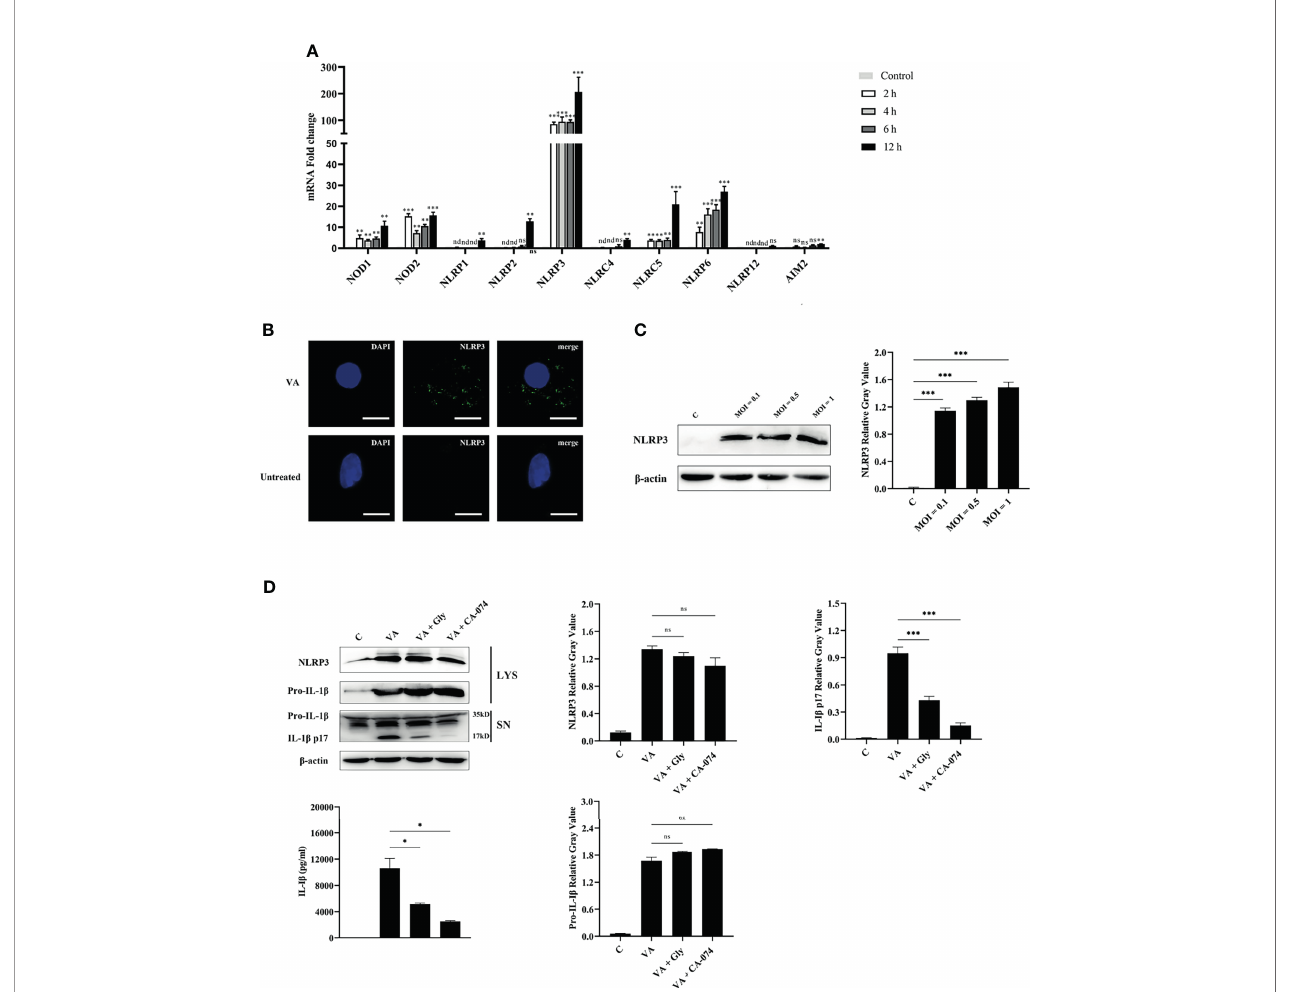
FIGURE 3 | NLRP3 in fl ammasome was activated in V. alginolyticus -infected macrophages and played vital roles in IL-1 b secretion. (A) Macrophages were infected with V. alginolyticus at an MOI of 1 for 2, 4, 6, and 12 h, and then the mRNA levels of patterns recognize receptors including NOD1, NOD2, NLRP1, NLRP2, NLRP3, NLRC4, NLRC5, NLRC6, NLRP12, and AIM2 were detected using qPCR. Data represented the mRNA fold change compared with the control group standardized to b -actin. (B) Mouse peritoneal macrophages were infected with V. alginolyticus (MOI = 1) for 12 h, and then the localization of NLRP3 protein was visualized by immuno fl uorescent staining. The green signals represent FITC-labeled NLRP3 protein, and the blue signals represent DAPI-stained nucleus. (C) Macrophages were infected for 12 h with V. alginolyticus at MOIs of 0.1, 0.5, and 1. The levels of NLRP3 in the cell lysates were detected by Western blotting, and the relative gray value was analyzed using ImageJ. (D) Mouse peritoneal macrophages were pretreated with 50 m M glyburide or 25 m M CA-074 methyl ester for 1 h and then infected with V. alginolyticus at a MOI of 1 for 12 h The protein expression levels of NLRP3, pro-IL-1 b , and IL-1 b were examined by Western blotting combined relative gray analysis, and the IL-1 b levels in the cell supernatants were also detected by ELISA. Data were representative of at least three repetitive experiments. * p < 0.05, ** p < 0.01, *** p < 0.001, ns, not signi fi cance, and nd, not